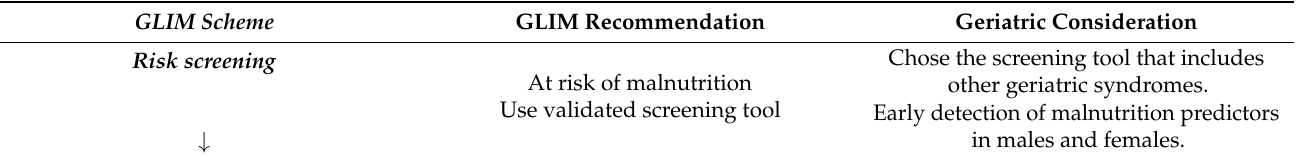
Table 1. Proposal of GLIM scheme and recommendations for adjustments for older